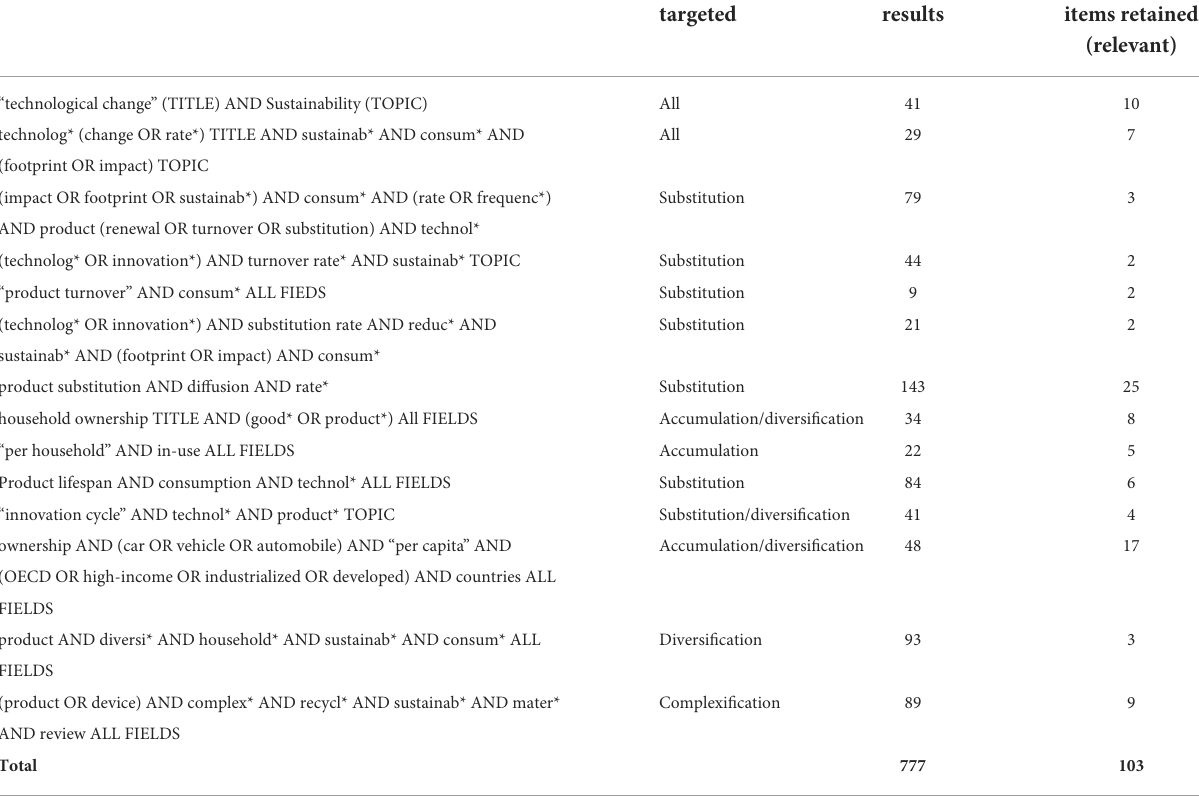
TABLE 1 Details of the search queries